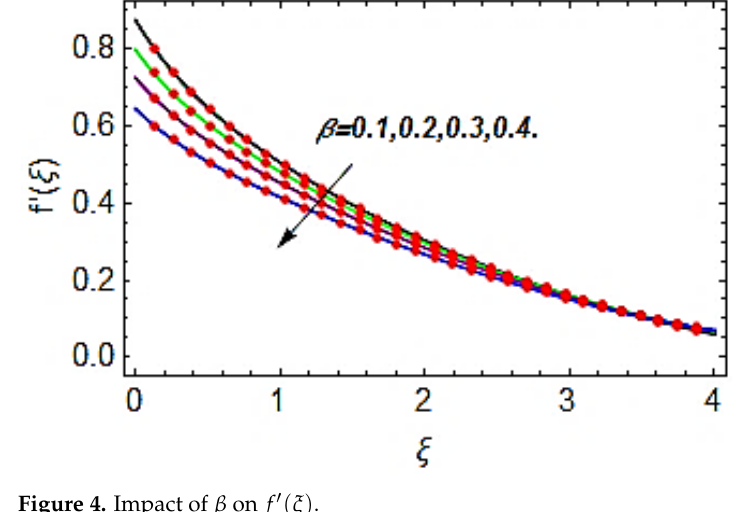
Figure 4. Impact of β on f (cid:48) ( ξ ) .